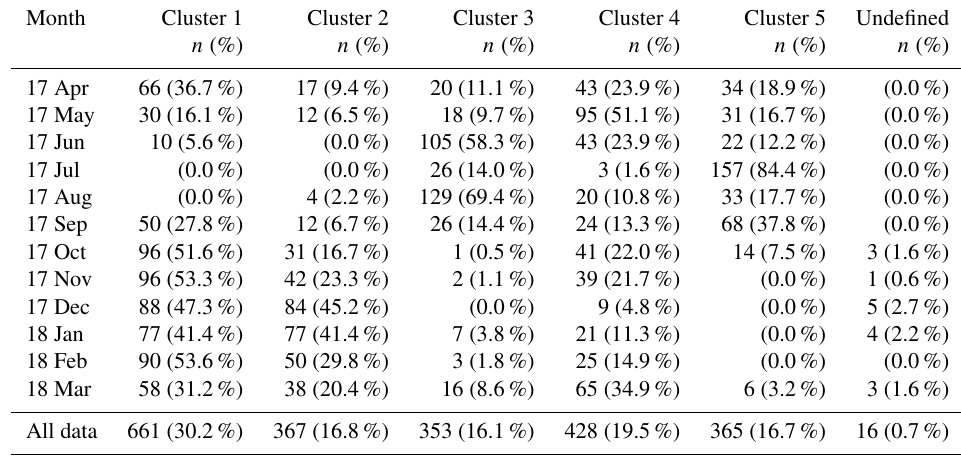
All data 661 (30.2%)